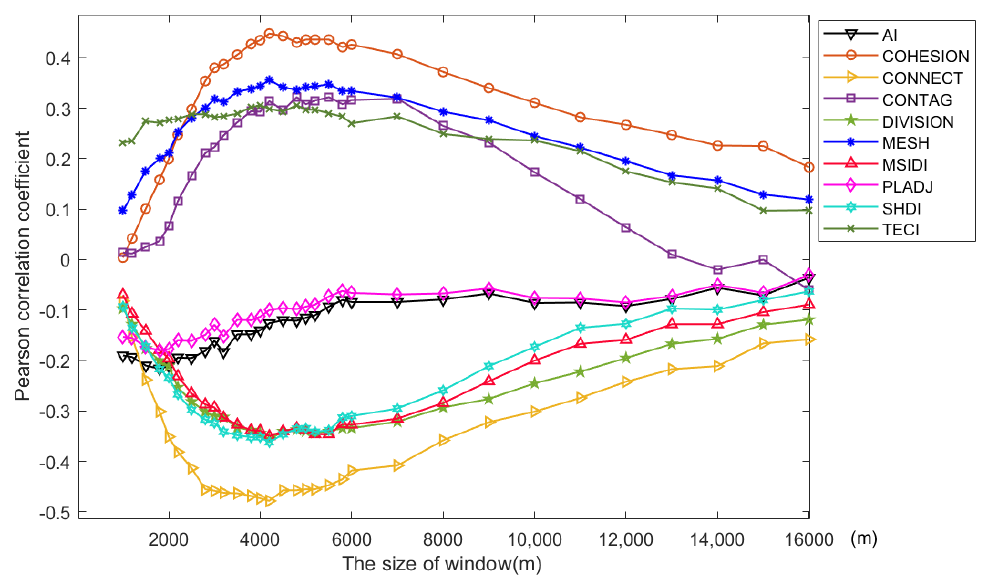
Figure 2. The figure of Pearson correlation coefficient. Note: AI: Aggregation Index, COHESION: Patch Cohesion Index, CONNECT: Connectance, CONTAG: Contagion, DIVISION: Landscape Division Index, MESH: Effective Mesh Size, MSIDI: Modified Simpson’s Diversity Index, PLADJ: Percentage of Like Adjacencies, SHDI: Shannon’s Diversity Index, TECI: Total Edge Contrast Index.